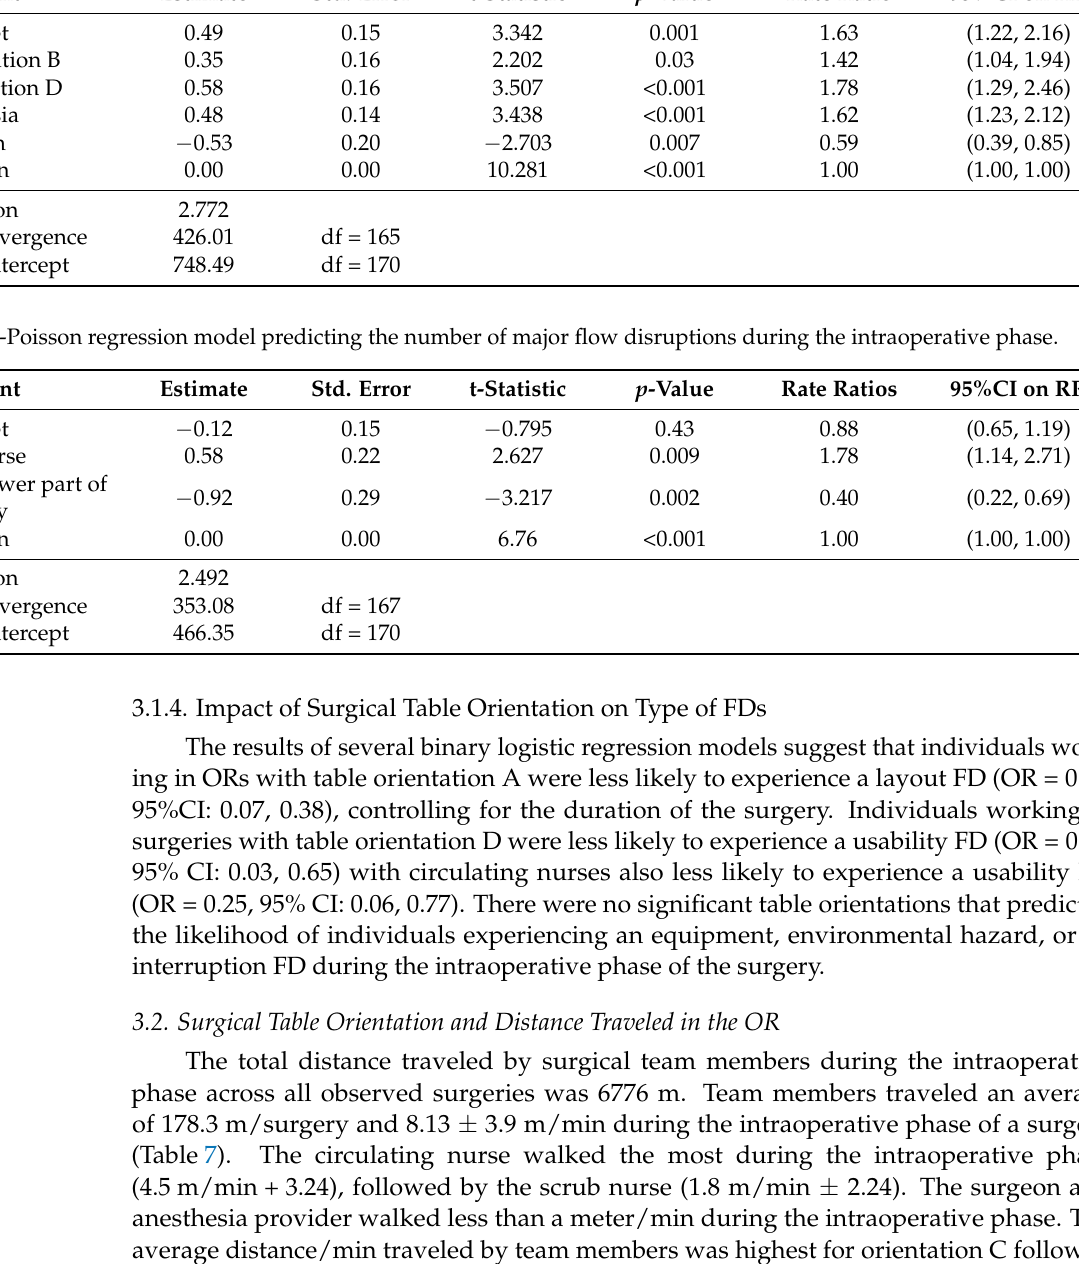
Table 5. Quasi-Poisson regression model predicting the number of minor flow disruptions during the intraoperative phase. Coefficient Table Orientation B Table Orientation D